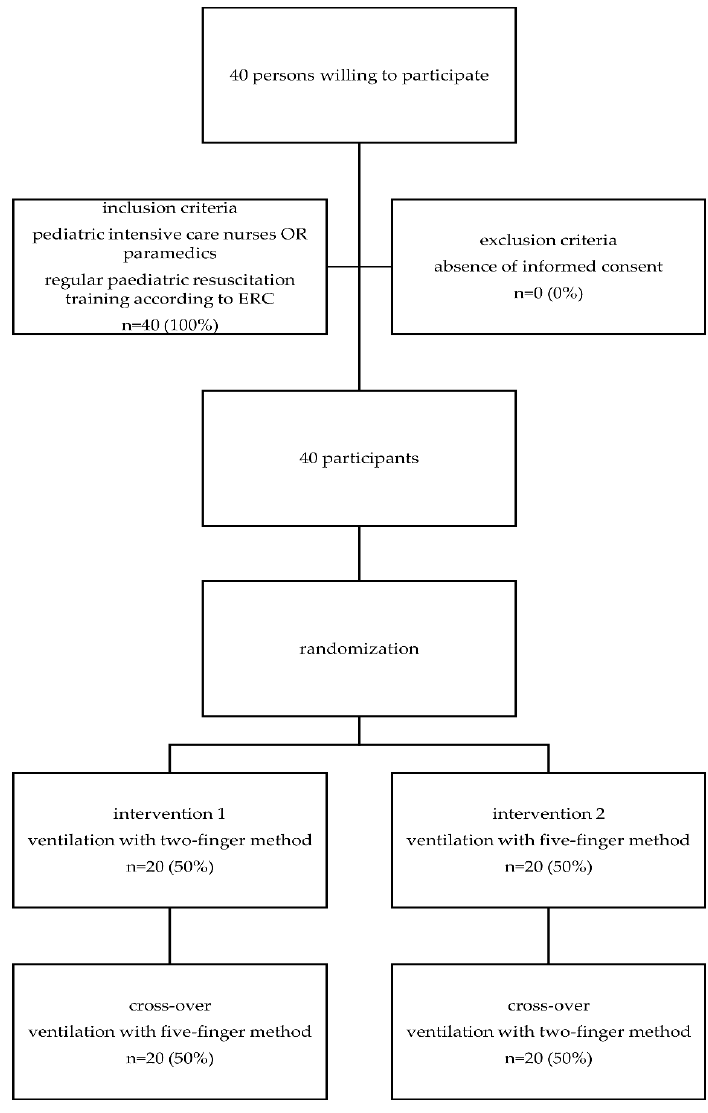
Figure 2. Study flow diagram. ERC—European Resuscitation Council.